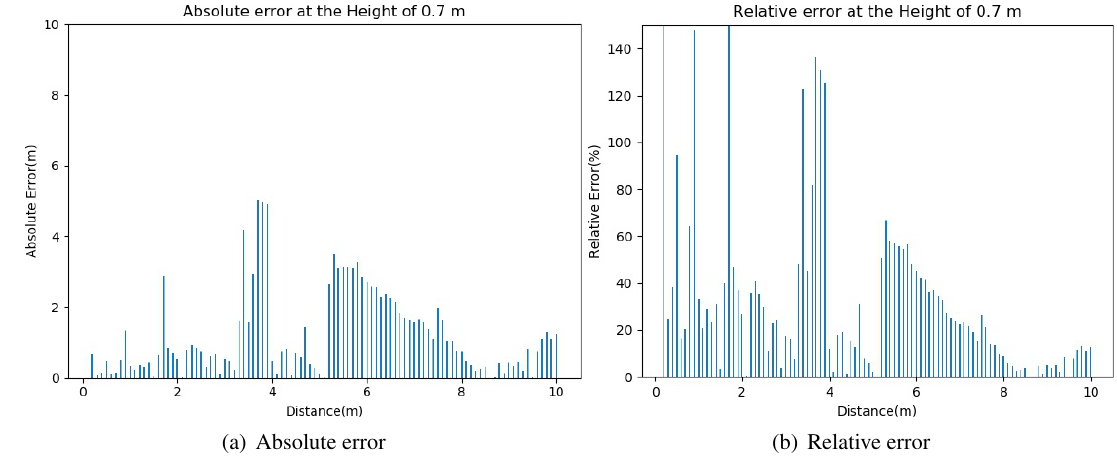
Fig. 4 Errors after supervised